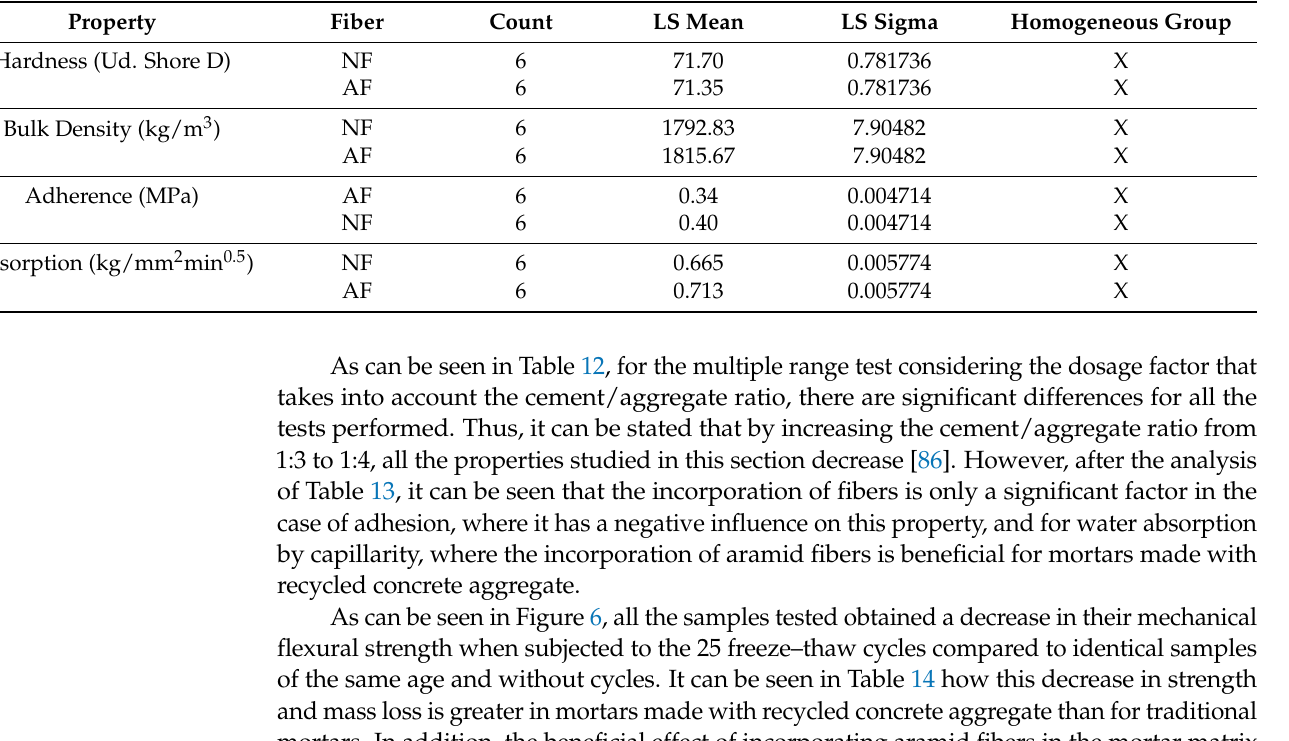
Table 13. Multi-range test the complementary tests considering the incorporation of aramid fibers.